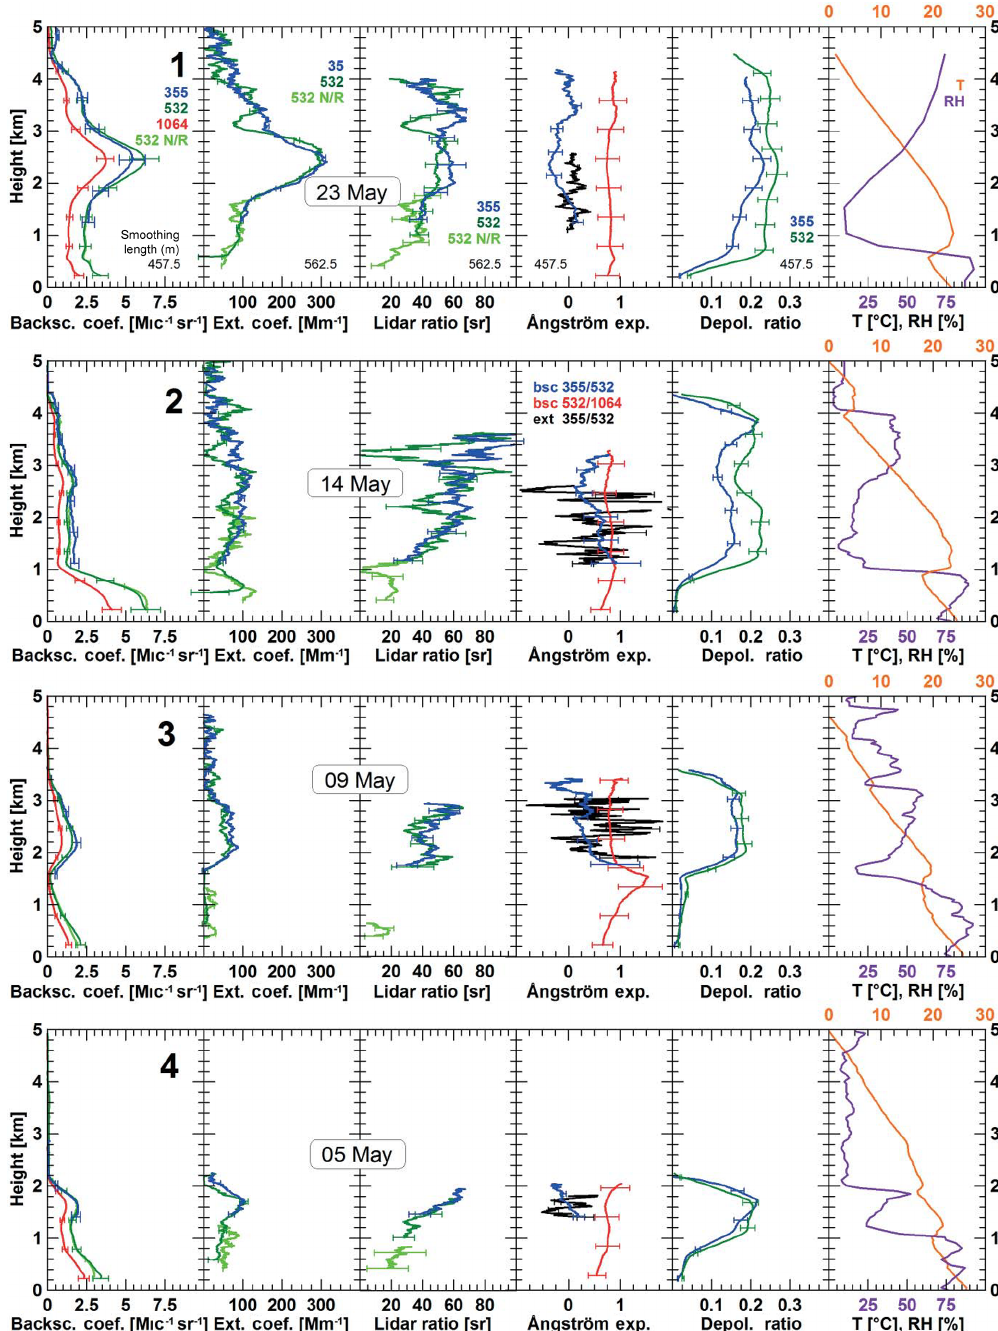
Figure 4. Profiles of the particle backscatter coefficient at 355, 532, and 1064nm; extinction coefficient, extinction-to-backscatter ratio (lidar ratio), and particle linear depolarization ratio at 355 and 532nm; and backscatter-related (bsc) and extinction-related (ext) Ångström exponents. Temperature and relative humidity from radiosondes (cases 2–4) and GDAS data (case 1) are given in addition. Mean profiles of the optical properties for the time periods on 23 May 2013, 03:45–05:00UTC (case 1); 14–15 May 2013, 23:45–00:15UTC (case 2); 9 May 2013, 23:15–24:00UTC (case 3); and 5 May 2013, 23:40–24:00UTC (case 4) are shown. The label 532 N/R denotes the 532nm near-range receiver channel. The vertical signal smoothing length for the profiles of backscatter coefficient and particle linear depolarization ratio is 457.5m; the rest is smoothed with 562.5m window length. The signal-averaging periods are indicated by white vertical lines in Fig.